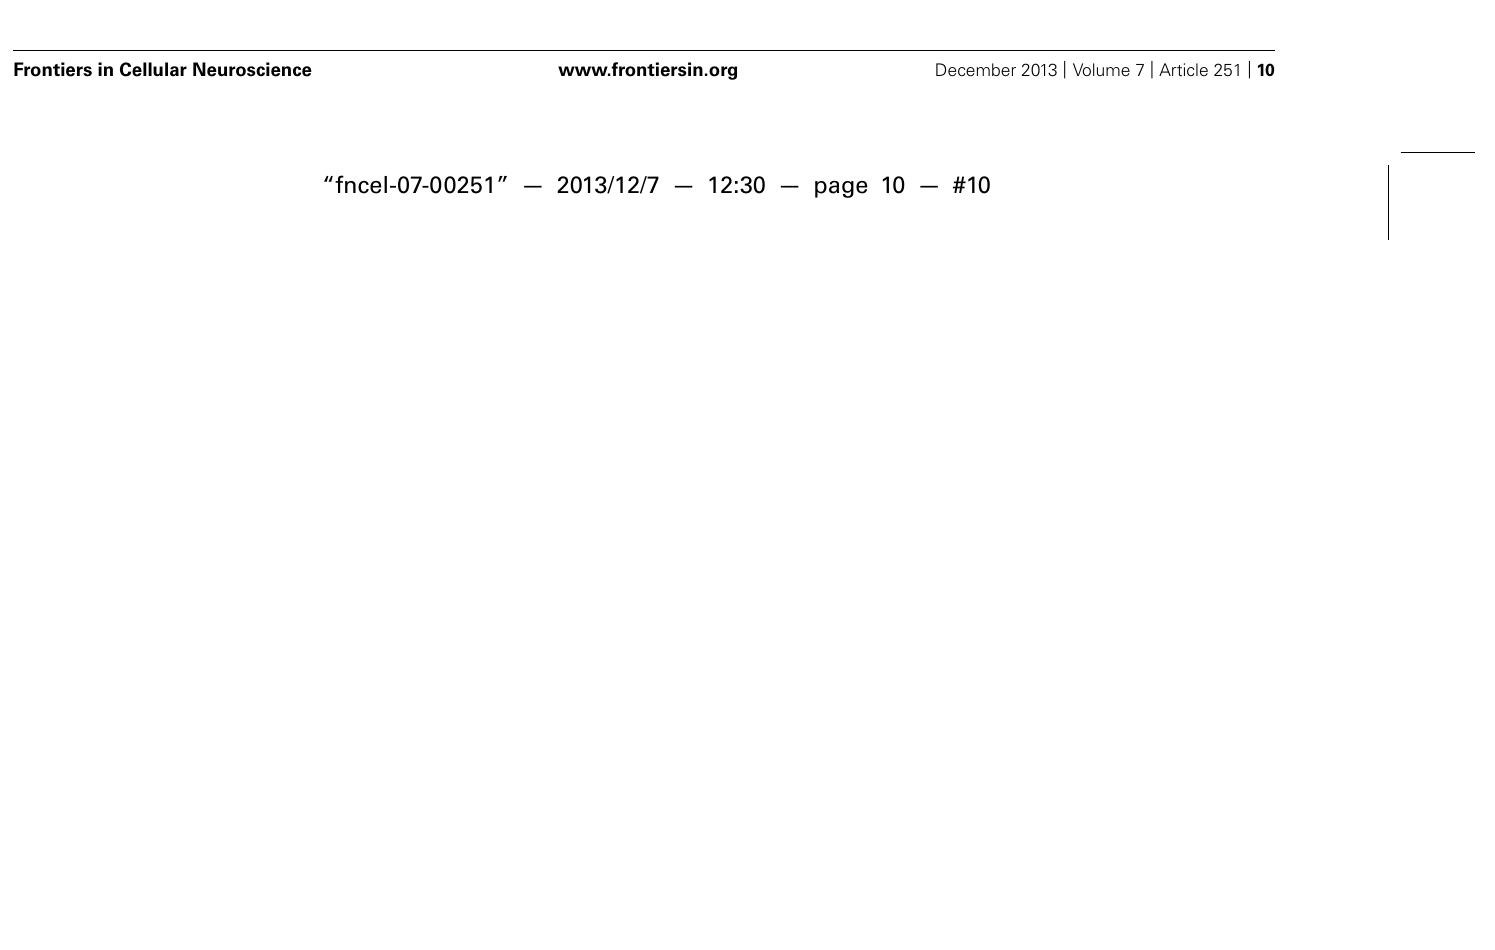
NeuN (red). (C,D) EAAT-2 (green) is found in both astrocytes and some scattered neurons. Inserts show higher magnifications. Scale bar, 100 μ